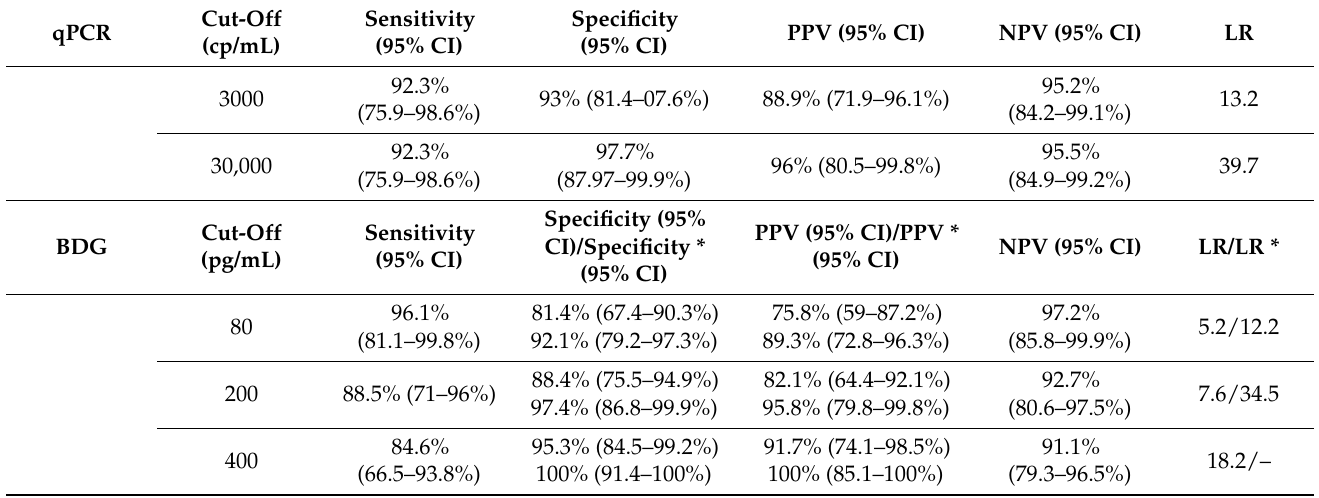
Table 1. Performances of BDG assay and molecular diagnosis for the diagnosis of PjP in 69 episodes from 67 HIV-positive patients as a screening